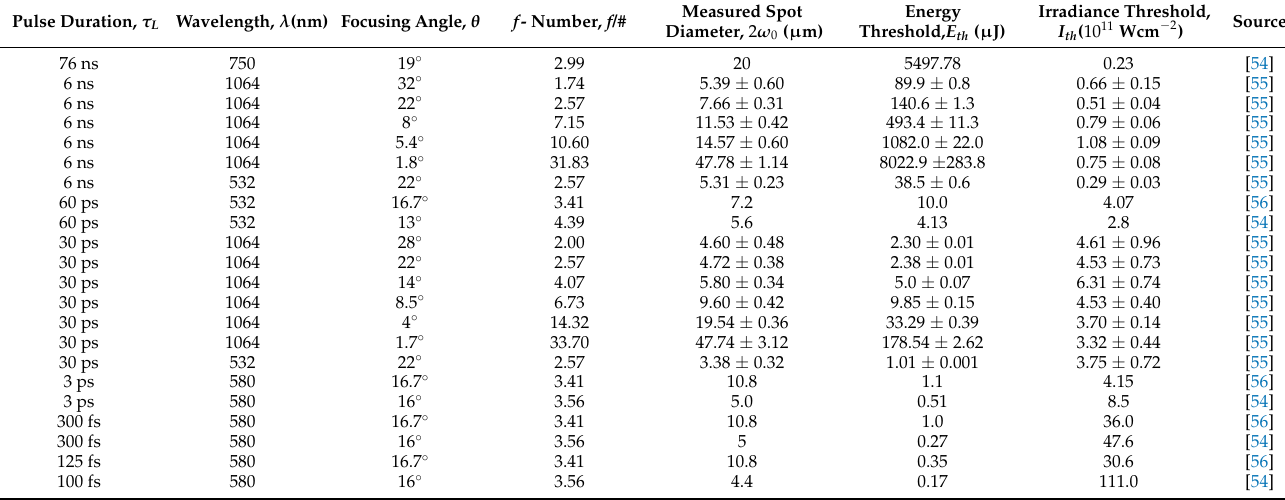
Table 1. Experimental optical breakdown thresholds for water for different pulse durations, wave- lengths, and focusing angles. The spot size is experimentally measured while the f -number is calculated using Equation